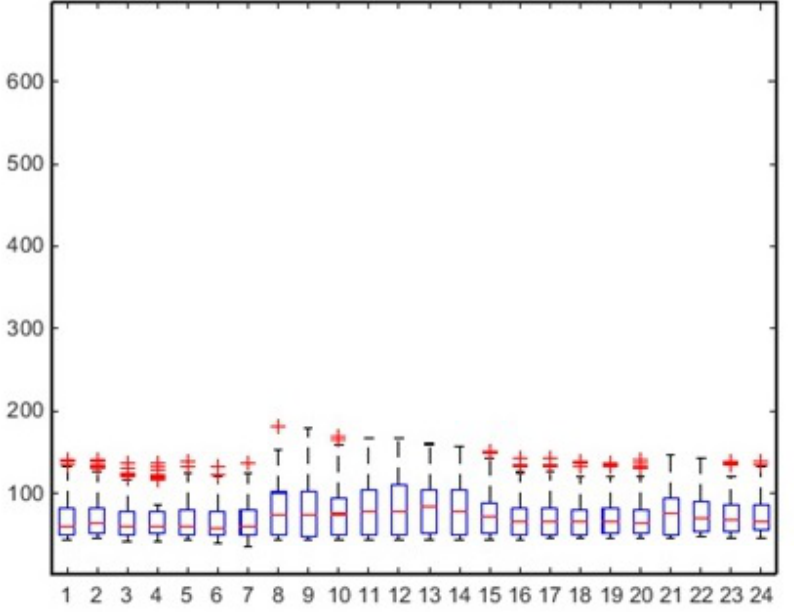
Figure 6. Pilot system: Municipal office (Monopoli). Box plots of weekend days power consumption. The x-axis reports day ours, while y-axis indicates power consumption